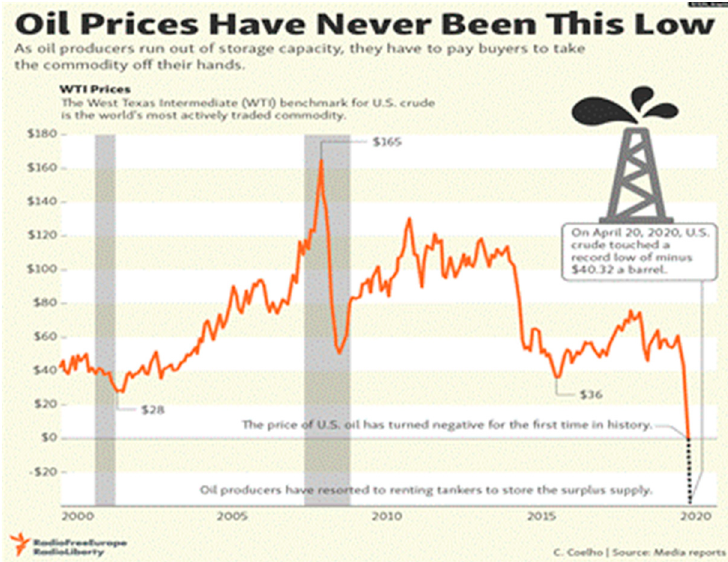
. . . Figure 6. WTI plunges to − $37.63, a historic negative price [12]. Copyright (c)2020 RFE/RL, Inc.